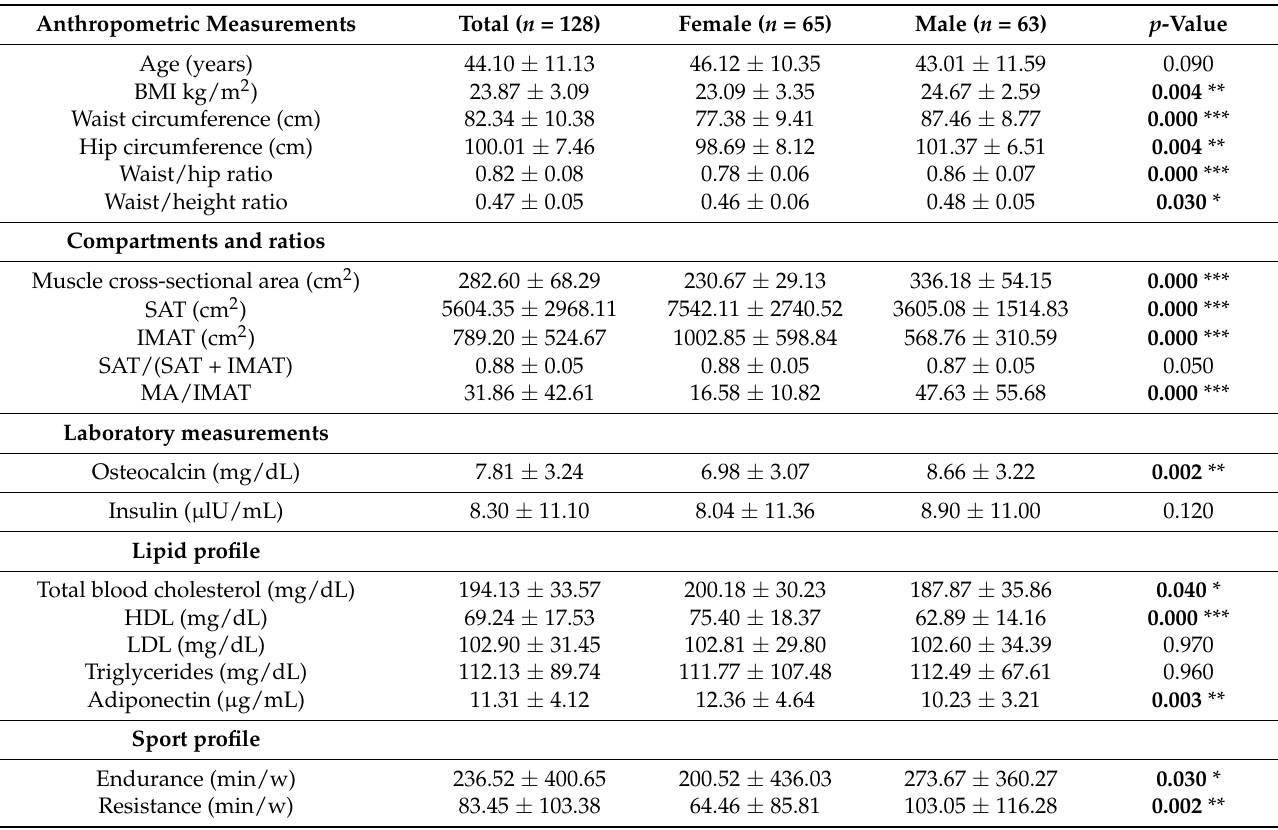
Table 1. Descriptive statistics of the study population, including anthropometric measurements. Areas of segmentation of cross-sectional muscle area and adipose tissues are shown along with laboratory parameters and duration of sport. Sex differences had been evaluated via Welch’s t -test. The shown p -values mark significant sex differences. (Values are reported as mean ±